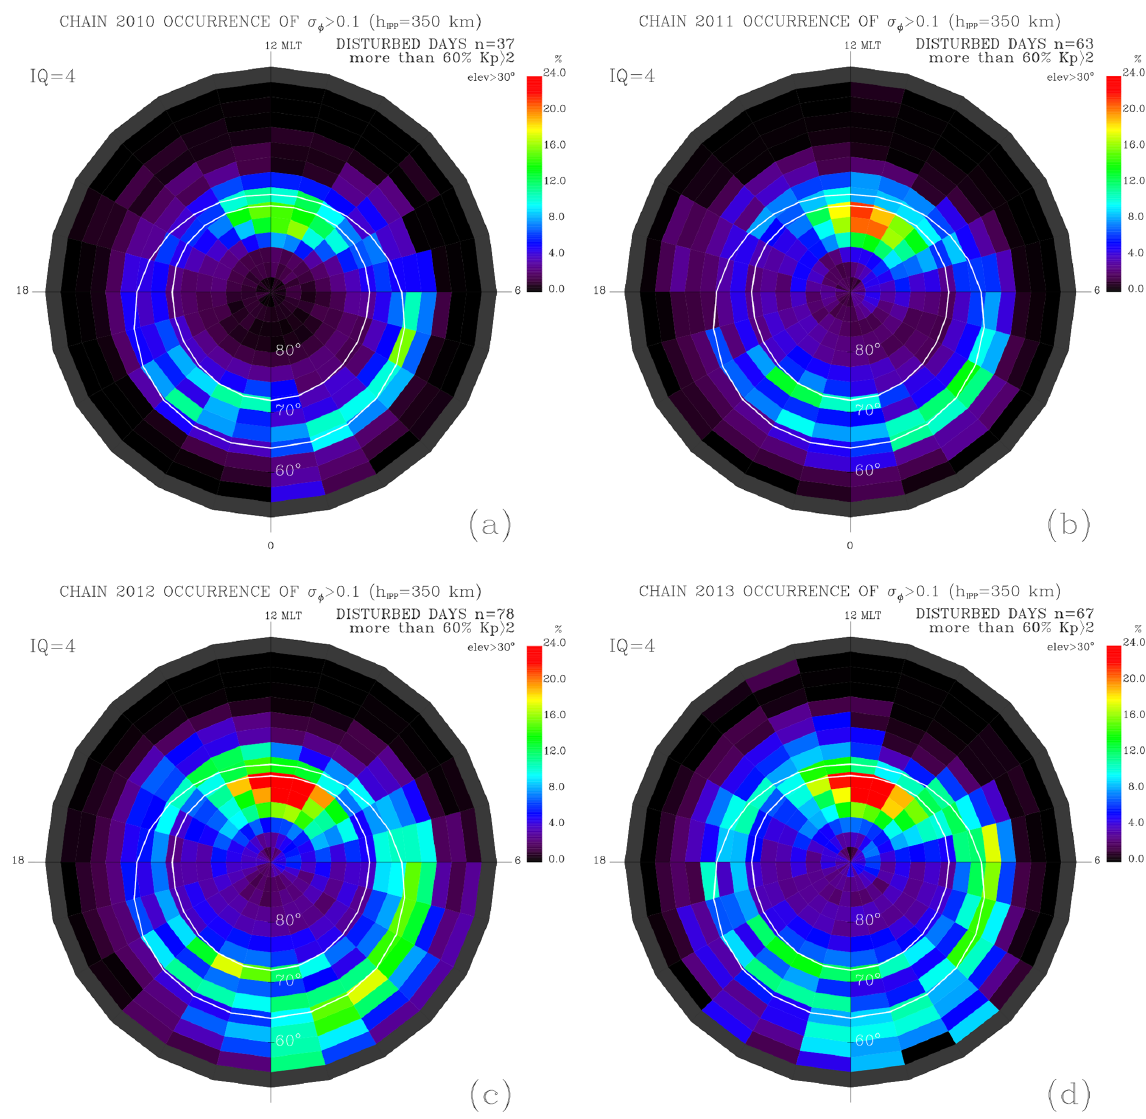
Figure 3. The yearly phase scintillation occurrence maps for geomagnetically disturbed days.